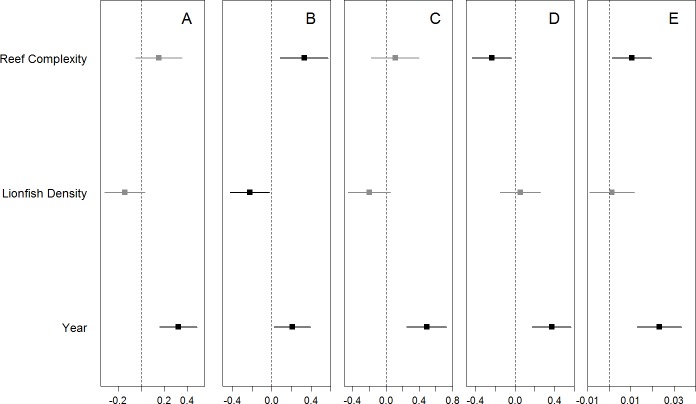
Coefficient estimates (mean ± 95% confidence interval) for each model.The site-averaged abundance of all potential prey fish (A), the abundance of the most common families (Pomacentridae, Labridae, and Scaridae B–D, respectively), as well as species richness (E) of potential prey fish were each modeled with the predictors of interest (lionfish abundance and years since the lionfish invasion) as well as site-specific reef complexity. Significant coefficient estimates are shown in black while non-significant coefficients are shown in gray (details in Table S3).